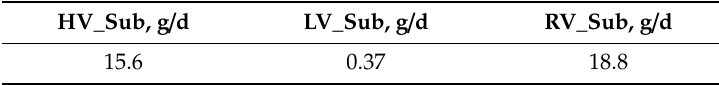
Table 8. Evaluation of the mass load for the three